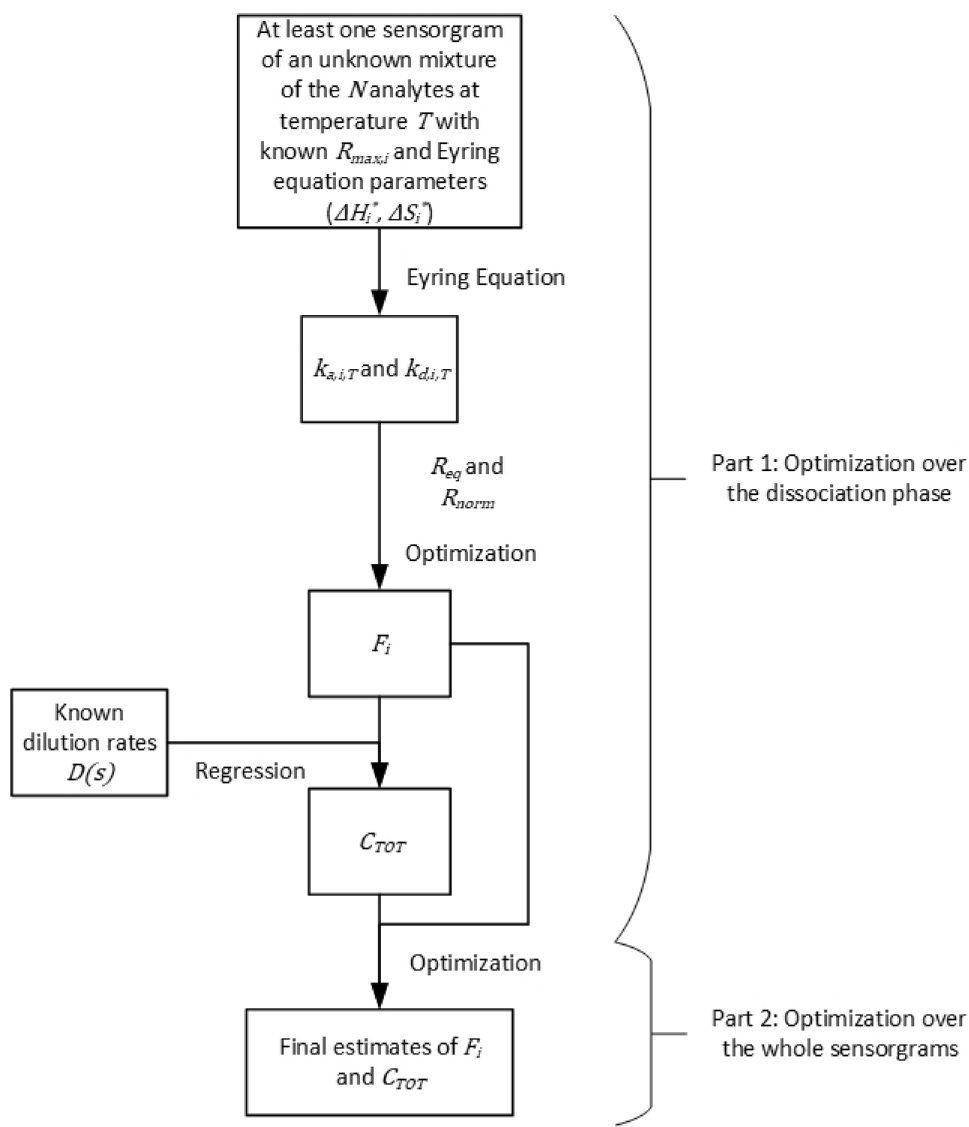
Figure 2. A two-part algorithm for the estimation of the composition and concentration of an unknown mixture of N analytes with known thermodynamic parameters. The unknown mixture is injected at temperature T for which corresponding kinetic parameters may be calculated using the Eyring equation. The first part of the algorithm surveys the dissociation phase of the sensorgrams to provide a first estimate of the fractions F i of each analyte. The starting point for this optimization routine is set to 1 / N . A first estimate of the total concentration C TOT can then be found via linear regression. The second part of the algorithm considers the whole sensorgrams to provide a final estimate of F i and C TOT . Note that, if sensorgrams of more than one total concentration are available, the corresponding dilution rates ( D ( s ) ) must be